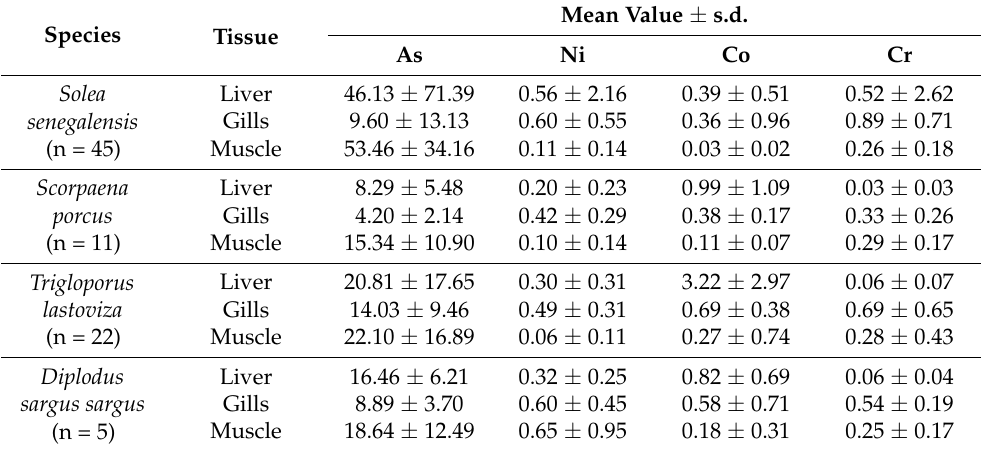
Table 5. Average metal concentration and standard deviation for each fish species